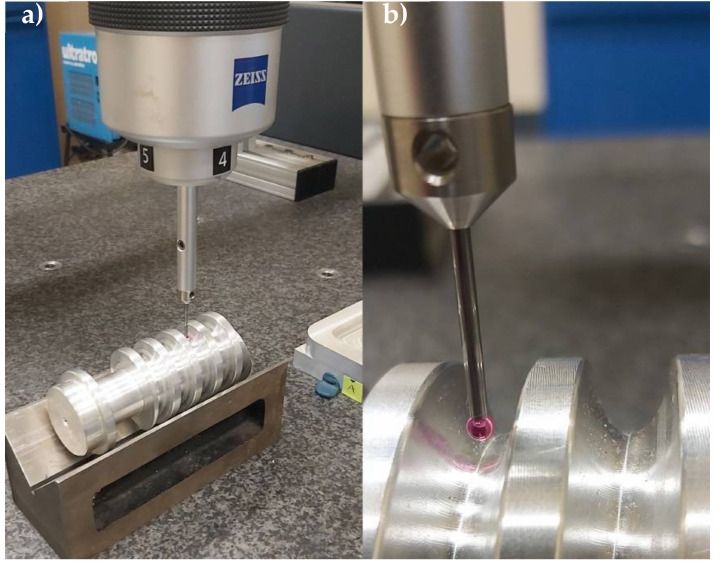
Figure 8. Measuring of concave profile on CMM Zeiss Eclipse: ( a ) worm fixed on the prism; ( b ) setting the measuring tip in the axial section of the